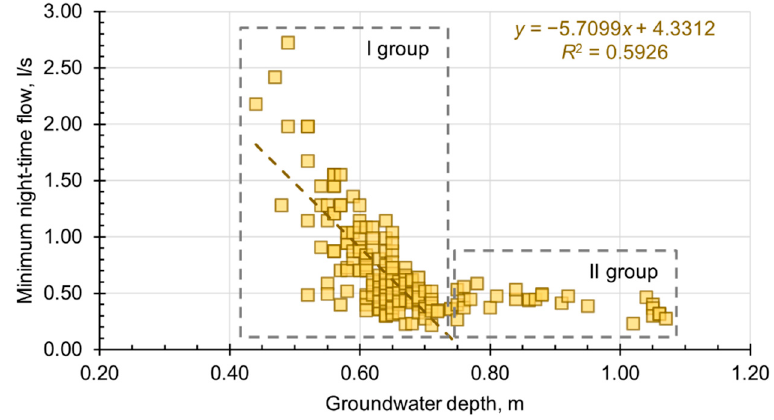
Figure 9. Scatter plot with trendline and regression equation for SC4.